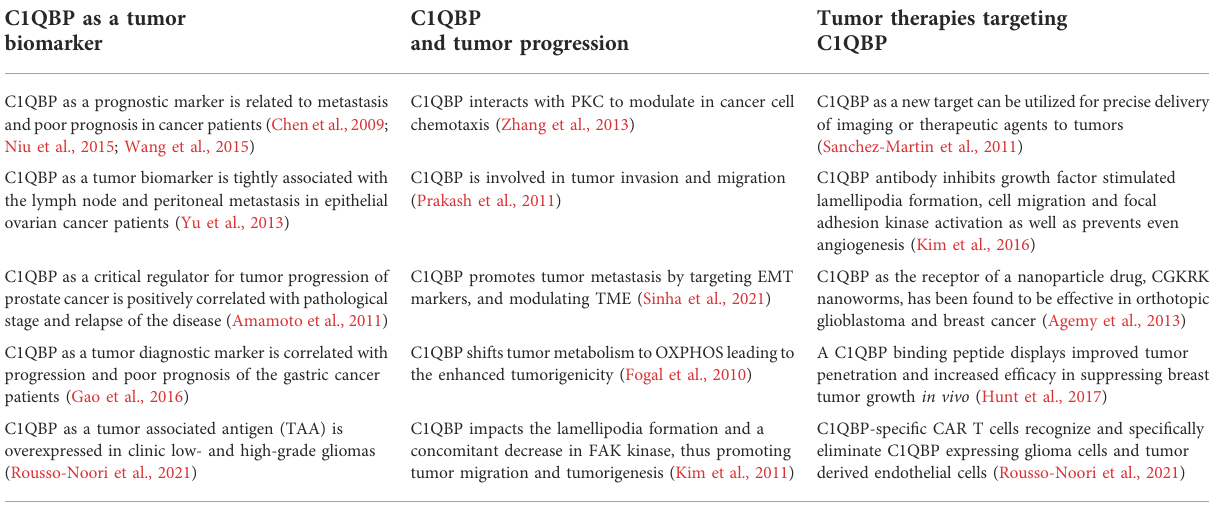
TABLE 1 C1QBP overexpressed in a variety of tumor cells is implicated in tumor malignant progression and tumor therapeutic